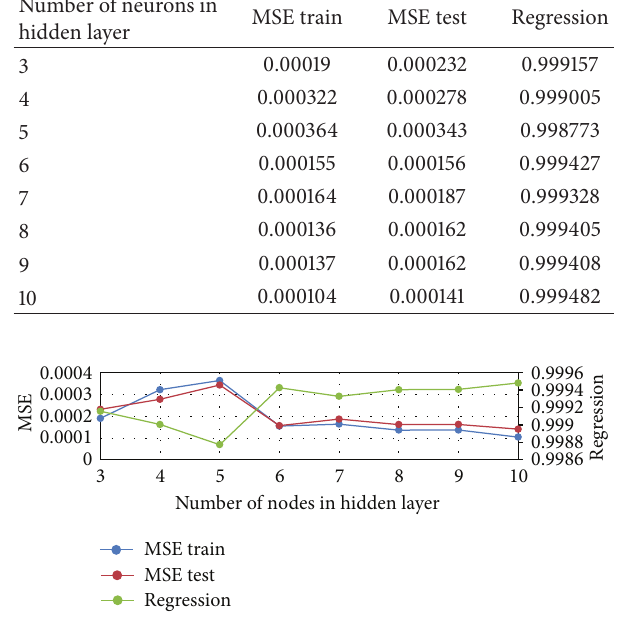
Figure 4: MSE with the number of nodes in hidden